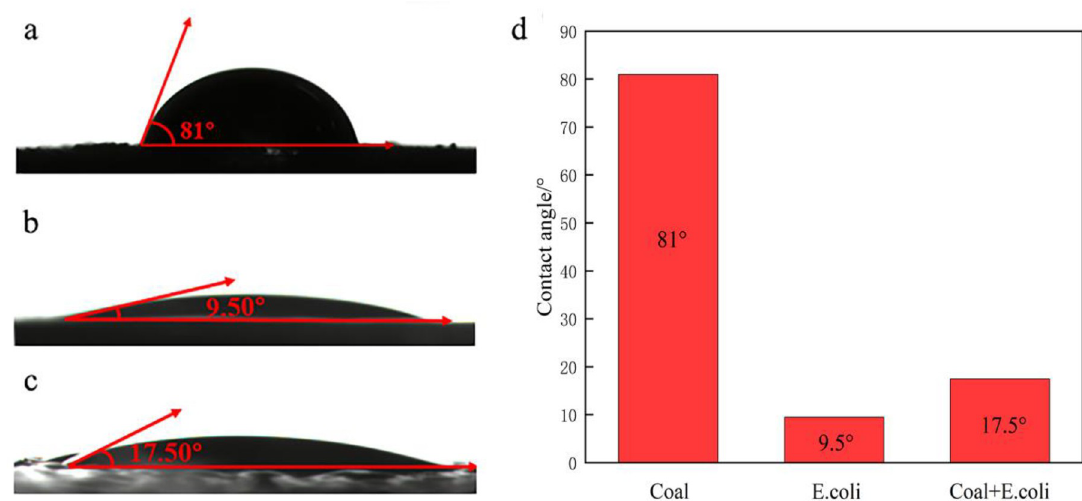
Fig 4. The contact angles of coal before and after interaction with E . coli (a) coal, (b) E . coli , (c) coal after interaction with E . coli , (d) The difference in contact angle before and after the interaction of coal with E . coli